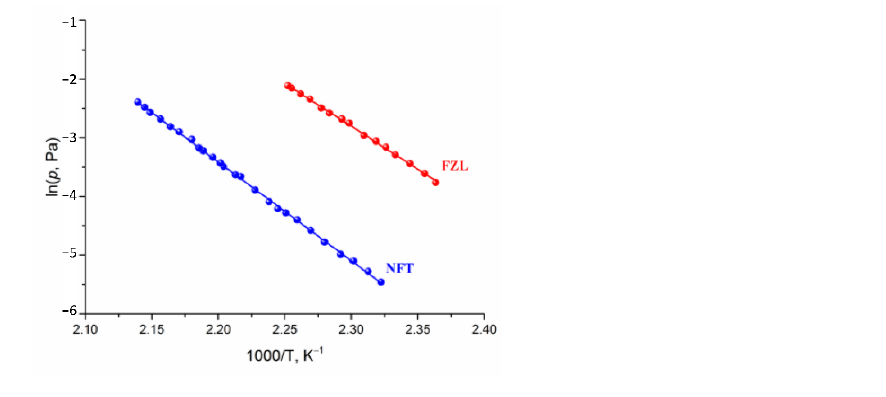
Figure 5. Plots of vapor pressure against reciprocal temperature of the compounds studied. Table 3. Sublimation thermodynamic parameters of the investigated